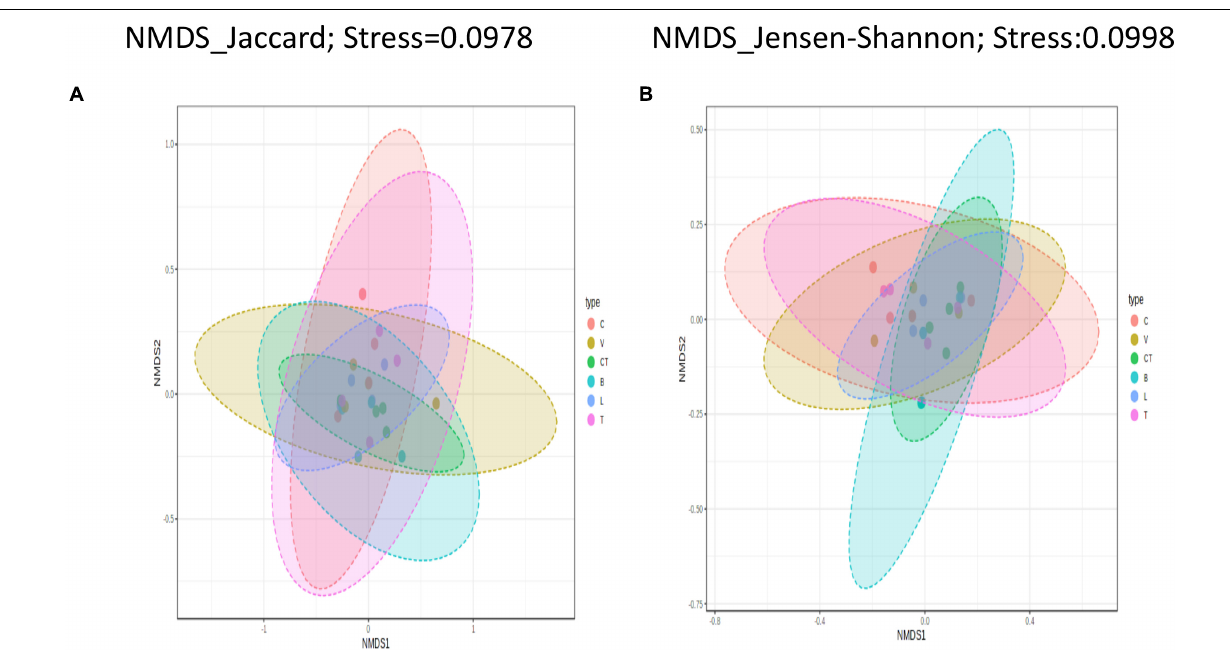
Frontiers in Microbiology |